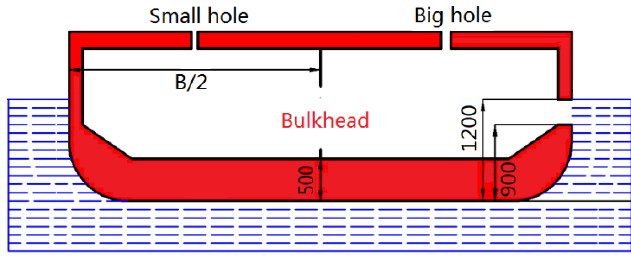
Figure 4. Environment conditions of the time simulation.